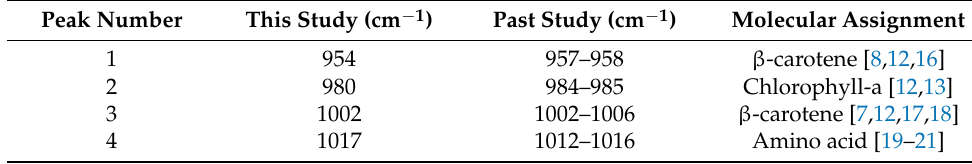
Table 1. Molecular assignment for each peak for Area 1. Table 2. Molecular assignment for each peak for Area